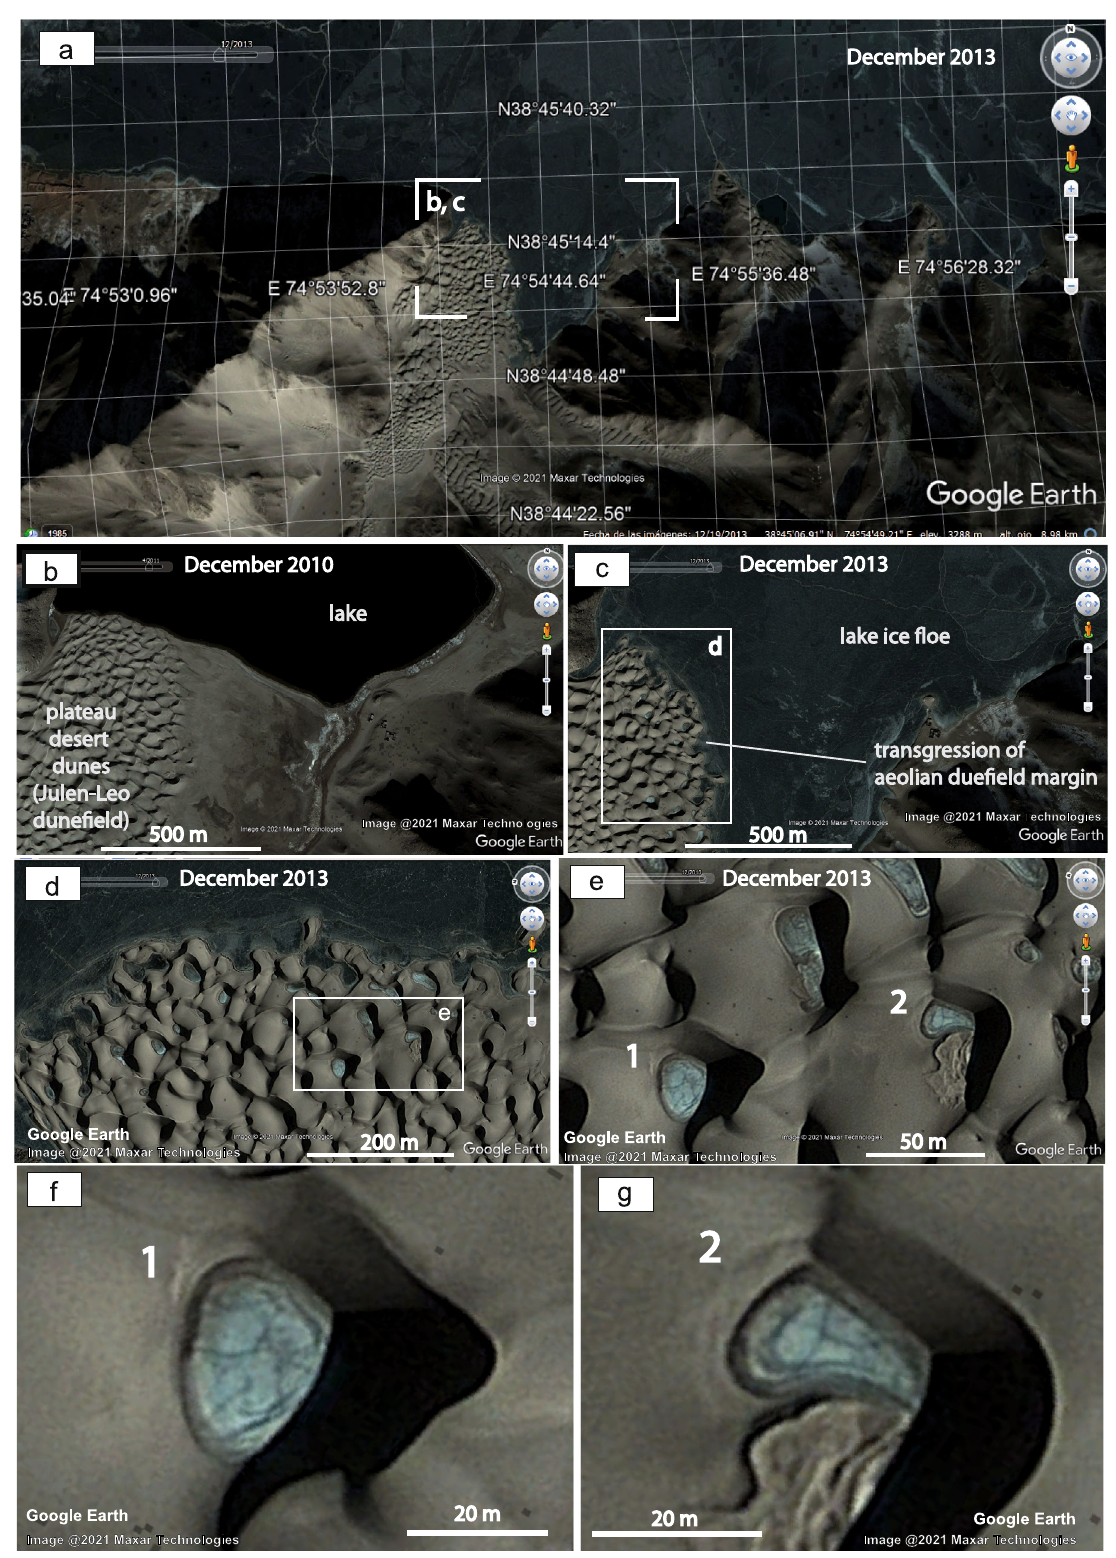
Fig. 4 | Close-up views of the plateau cold aeolian – lake system in the western Himalayas. a Southern margin of the Qiongkuai Lebashi Lake. b Image dated December2010,and c ImagedatedDecember2013,showingevidenttransgression of the lake shore and onto the aeolian dune fi eld. d Close-up view from c , rotated indicating the geographic north to the left of the image. See location in ( c ).